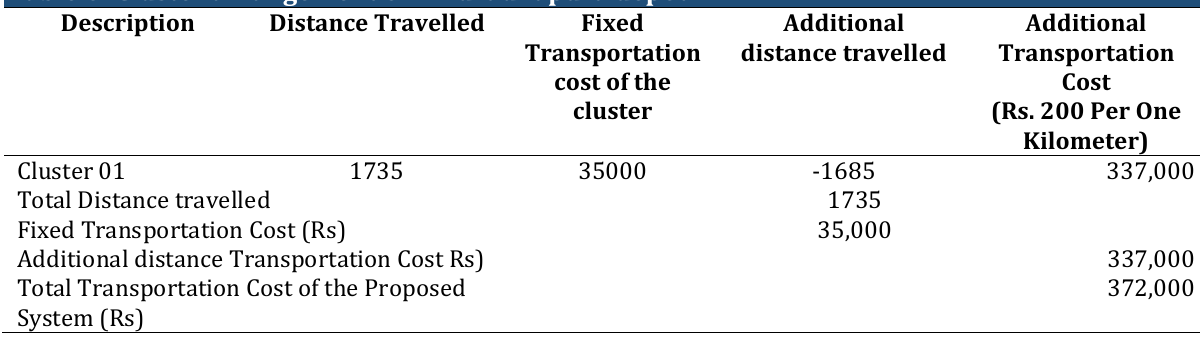
Table 6: Cluster arrangement on Anuradhapura depot